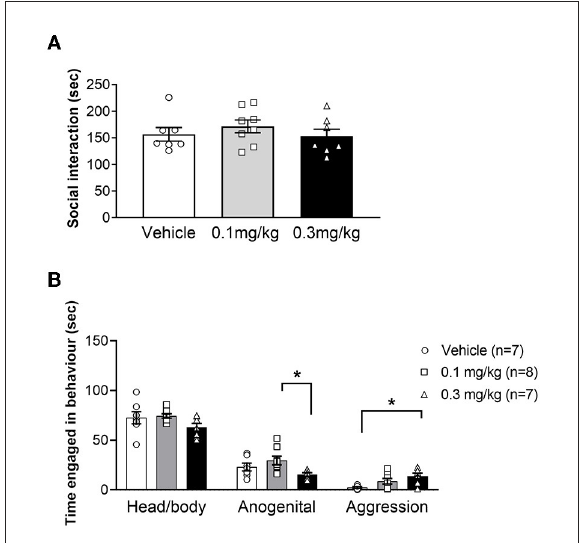
FIGURE3 Average time ( + /- SEM) spent engaged in social interaction (A) or specific social behaviors (B) in LH rats treated with vehicle (white bar), 0.1 mg/kg URB597 (gray bar) and 0.3 mg/kg URB597 (black bar), with individual values displayed as circles, squares and triangles, respectively. (A) URB597 had no effect on total SI in LH rats. (B) Rats treated with 0.3 mg/kg URB597 spent less time engaged in anogenital sniffing, compared with rats treated with 0.1 mg/kg URB597 (middle), and more time engaged in aggressive behaviors, compared with vehicle treated rats (right). Error bars represent + /- SEM. * p <